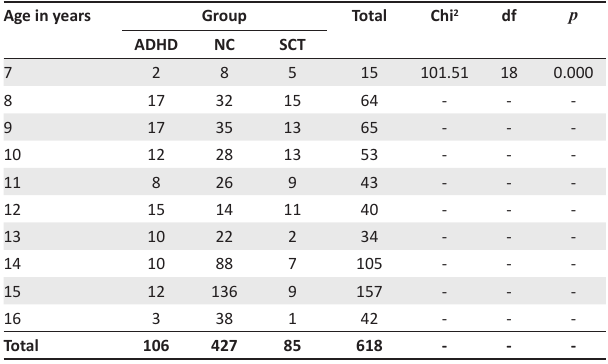
TABLE 3 : Age distribution in the three